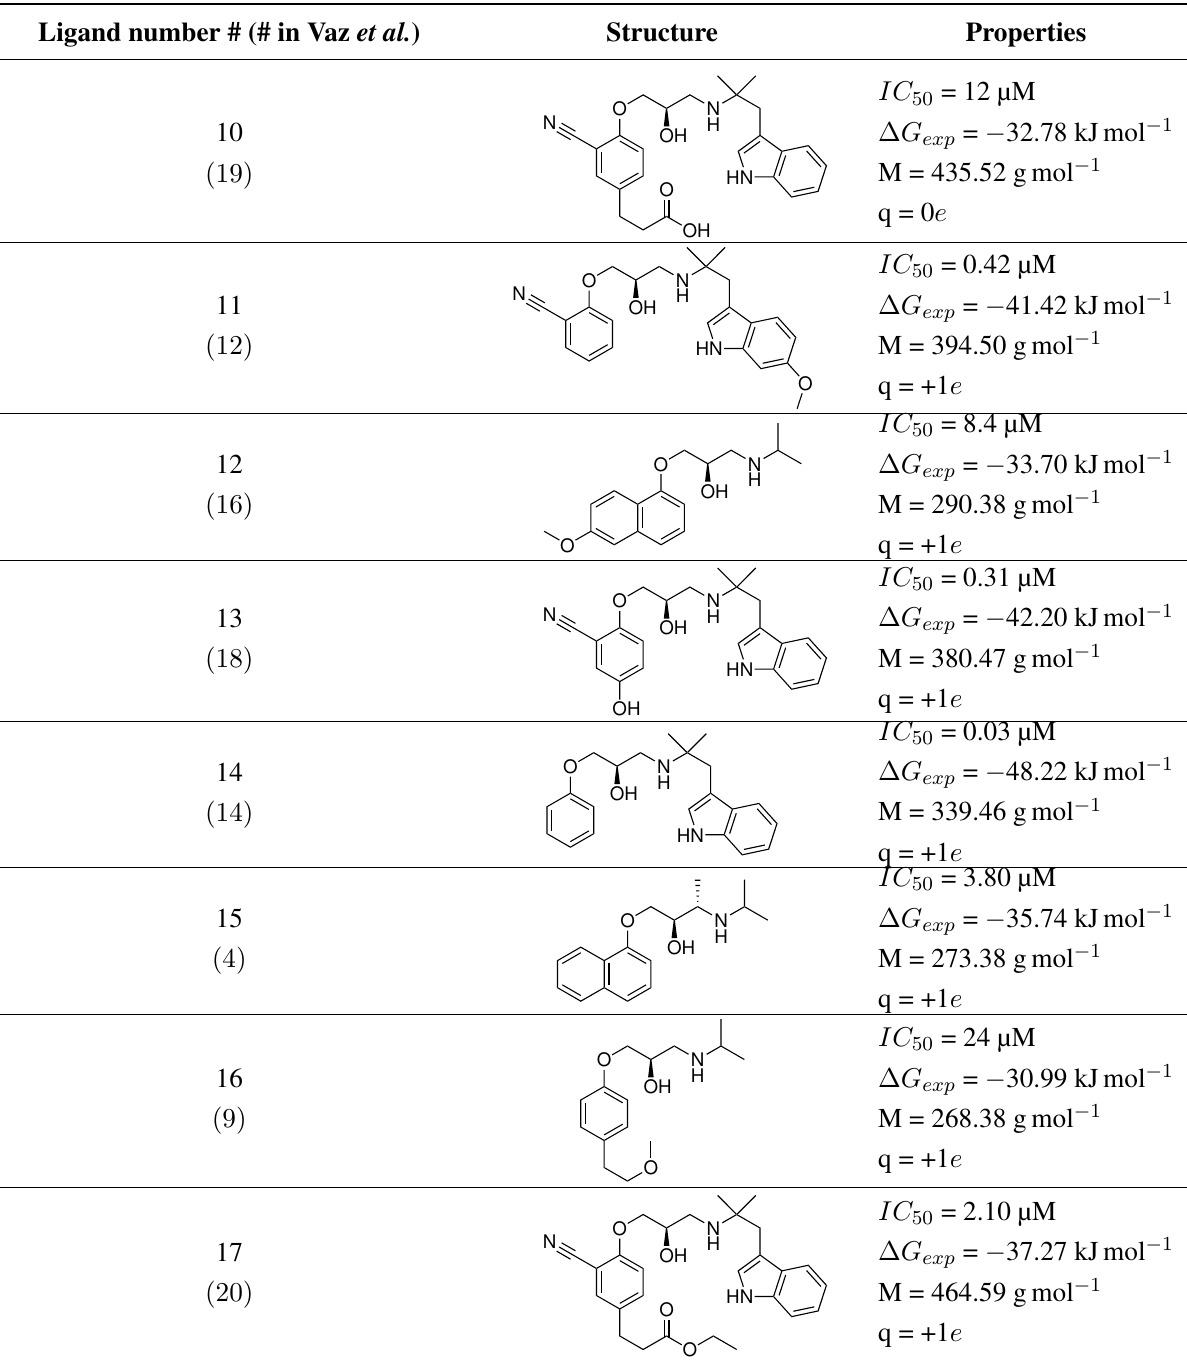
Table 2. Compounds used in testing of the presented CYP 2D6 LIE model for aryloxypropanolamines. Experimental values for IC ’s (reported by Vaz et al. [27]) and 50 derived binding free energies ( ∆ G ) are given, as well as molar masses (M) and net charges exp of the compounds (q). Ligand number # (# in Vaz et al. ) Structure